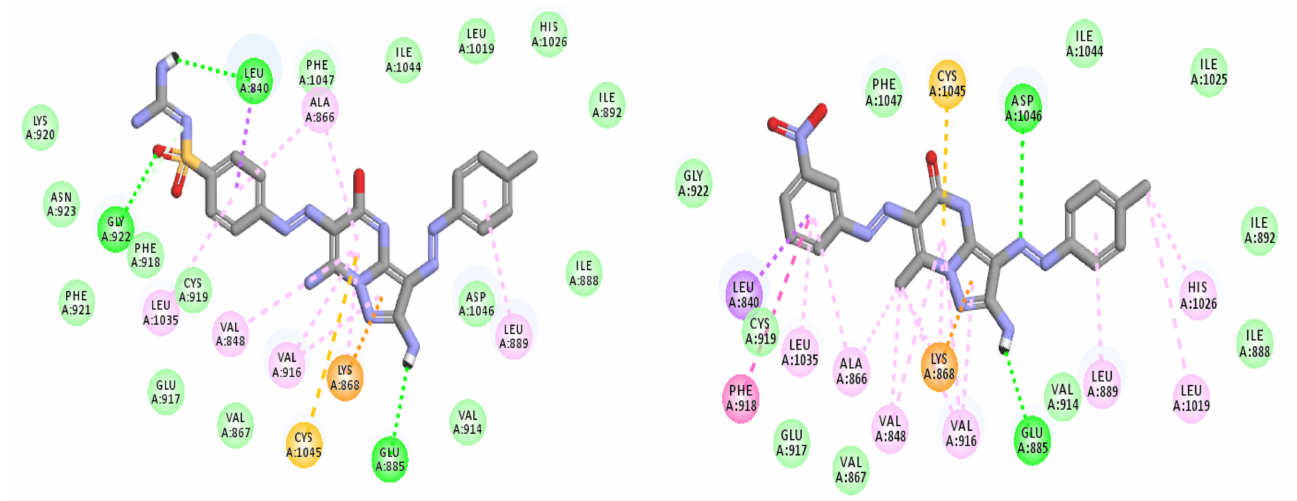
Figure 12. Two-dimensional representation of the interacting mode of 2a ( left panel ) and 4b ( right panel ) with VEGFR kinase. The H-bond interactions are represented by green dotted